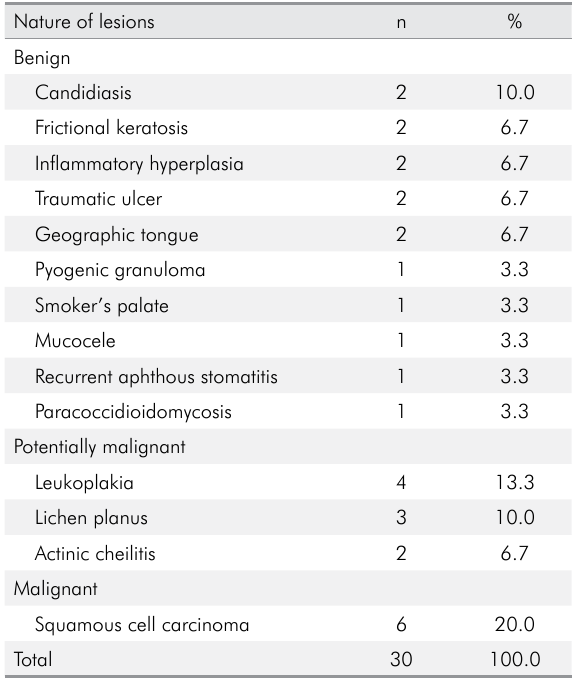
Table 2. Distribution of oral mucosal lesions included in the diagnostic ability test (n =